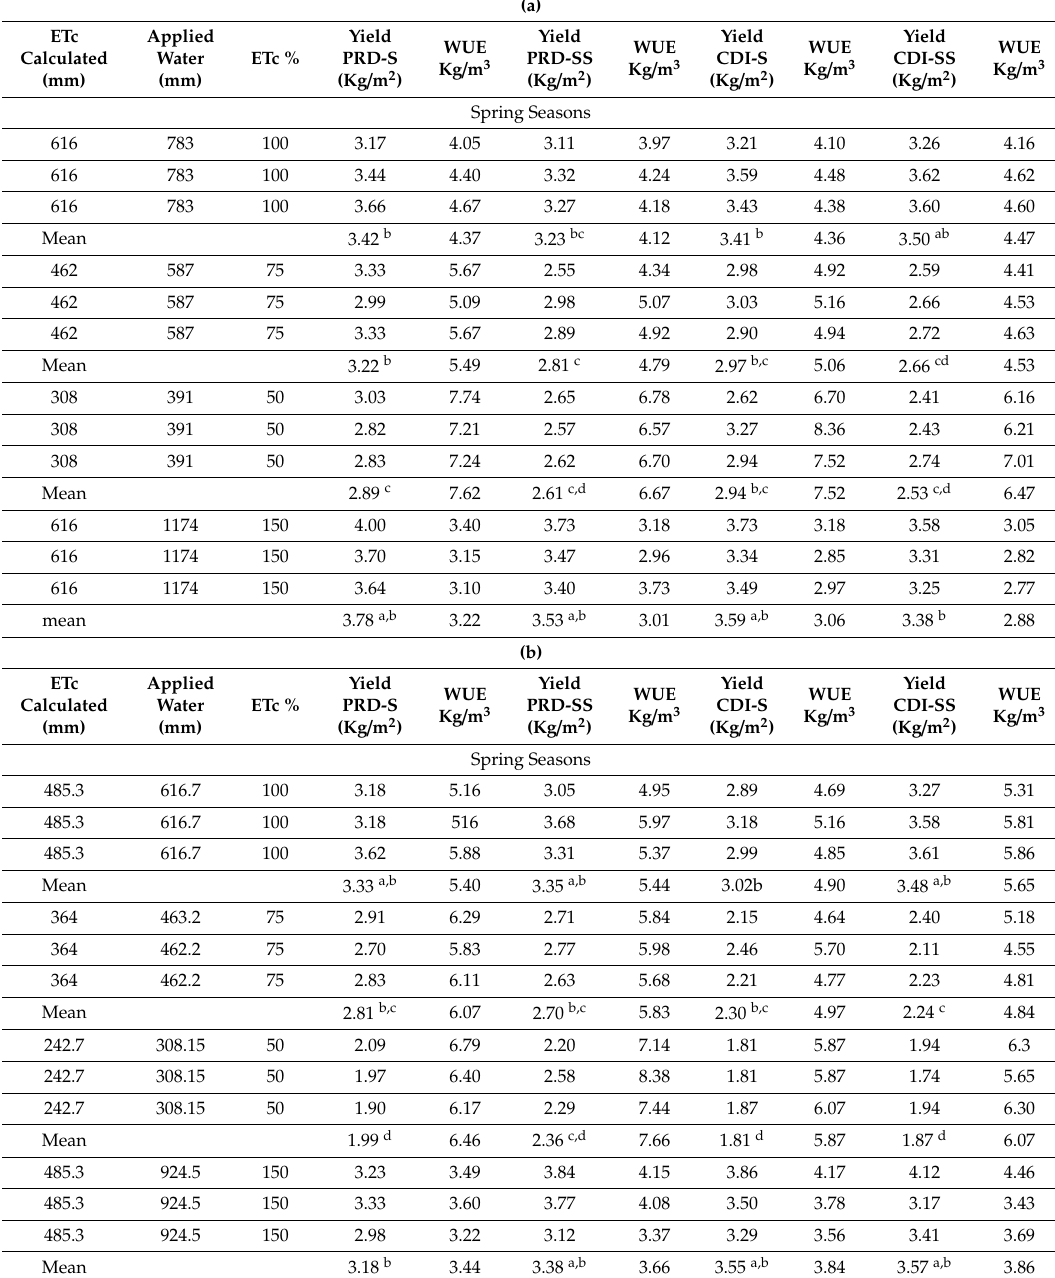
Table 6. ( a ) Yield of potato as a ff ected by PRD, deficit irrigation (DI), and full irrigation (Spring